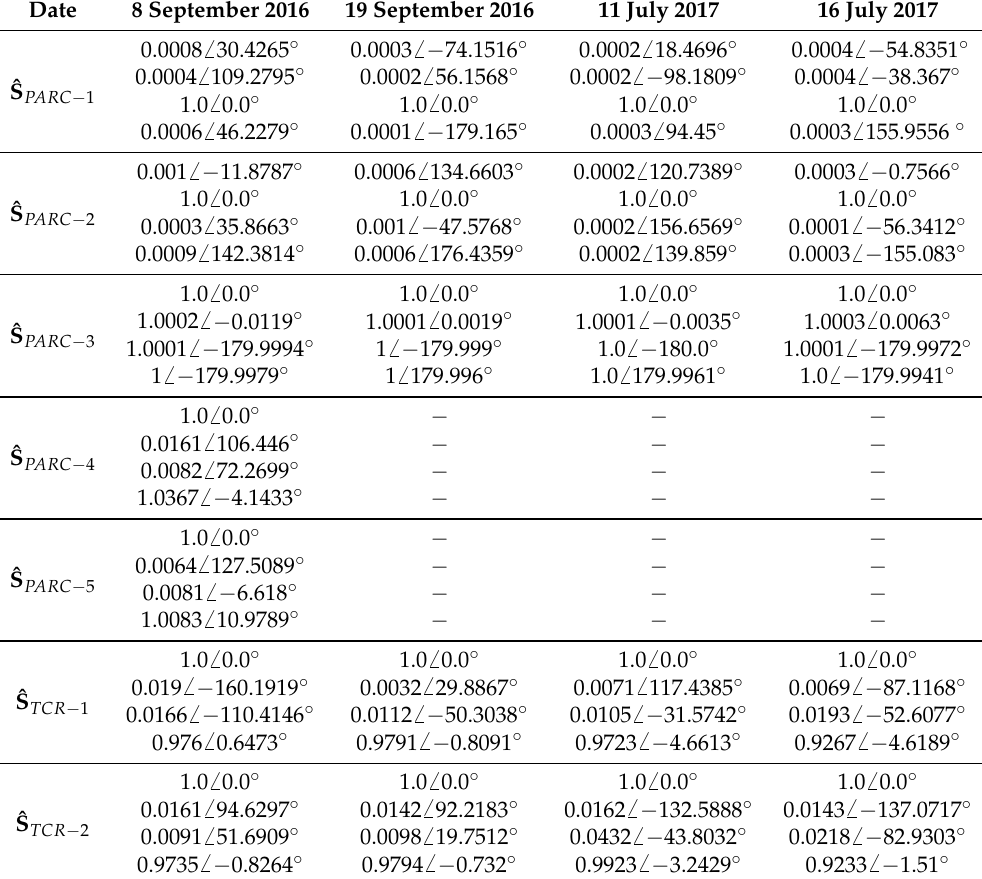
Table 3. The correction results by the polarimetric parameters from the improved algorithm of this